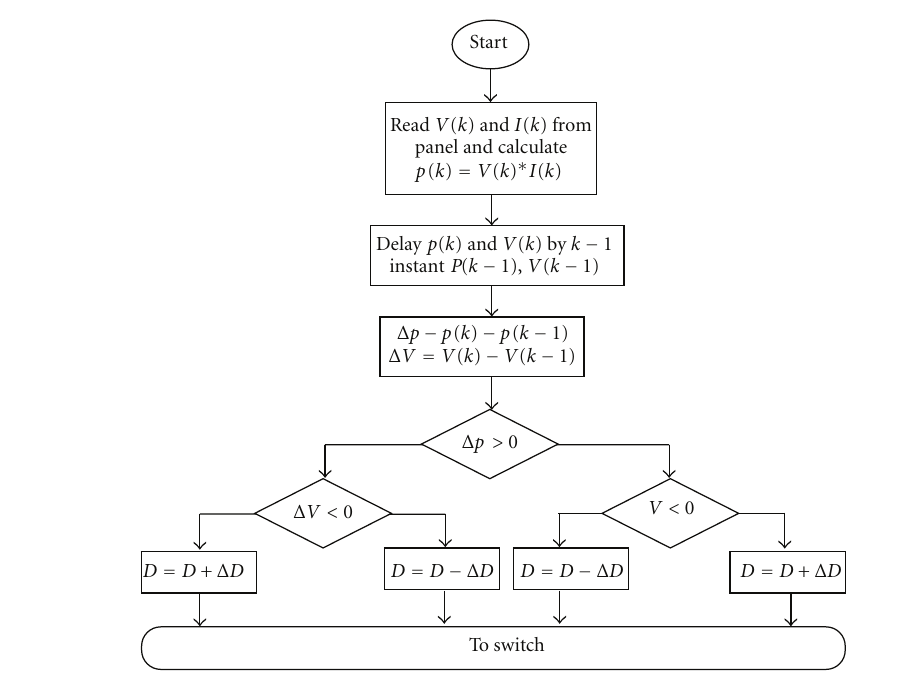
Figure 20: Flow chart of P&O MPPT algorithm.